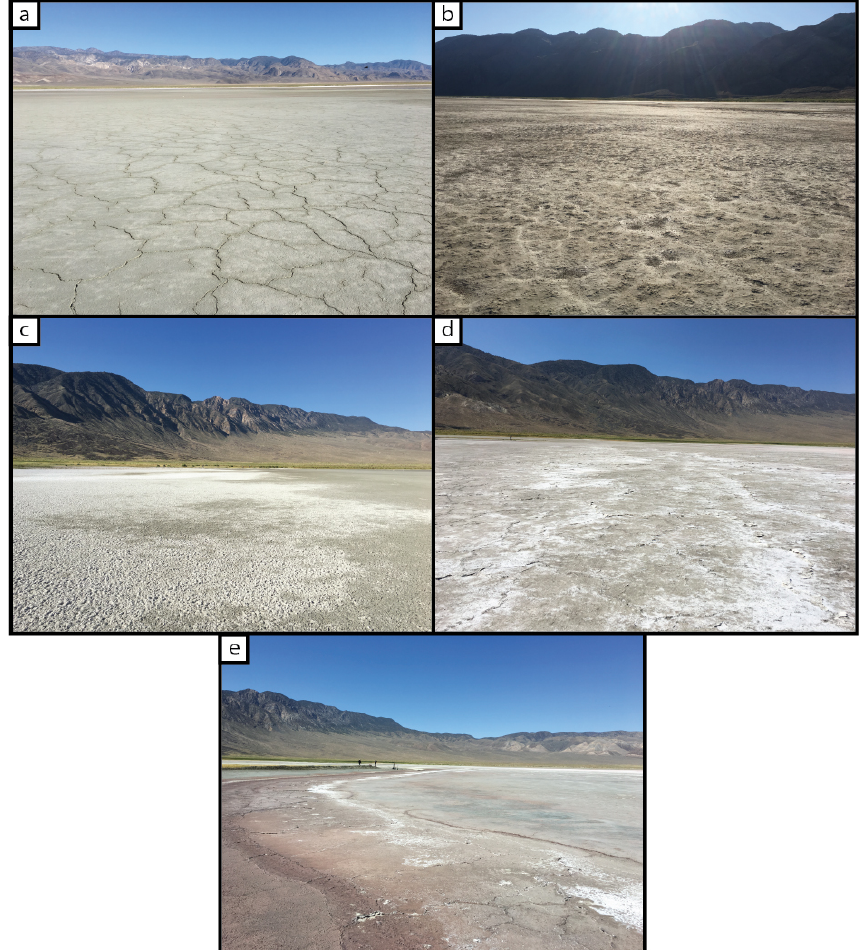
Figure 7. Surface texture changes across Deep Springs playa. Panels (a–e) show changes in surface texture moving from Deep Springs playa into Deep Springs Lake. (a) Large, flat, meter-scale polygonal fractures dominate the playa, especially in the drier outer regions that only become watered when it rains or snows. (b) Rougher, slightly raised surface with no cracks. (c) Raised polygonal fractures with curled edges with thin evaporites deposited primarily on these raised edges. (d) Small, centimeter-scale mudcrack on the eastern side of Deep Springs Lake that often experiences wetting from nearby springs. (e) Wettest accessible region of Deep Springs showing dark-brown surface. Polygonal fractures just beyond the edge of